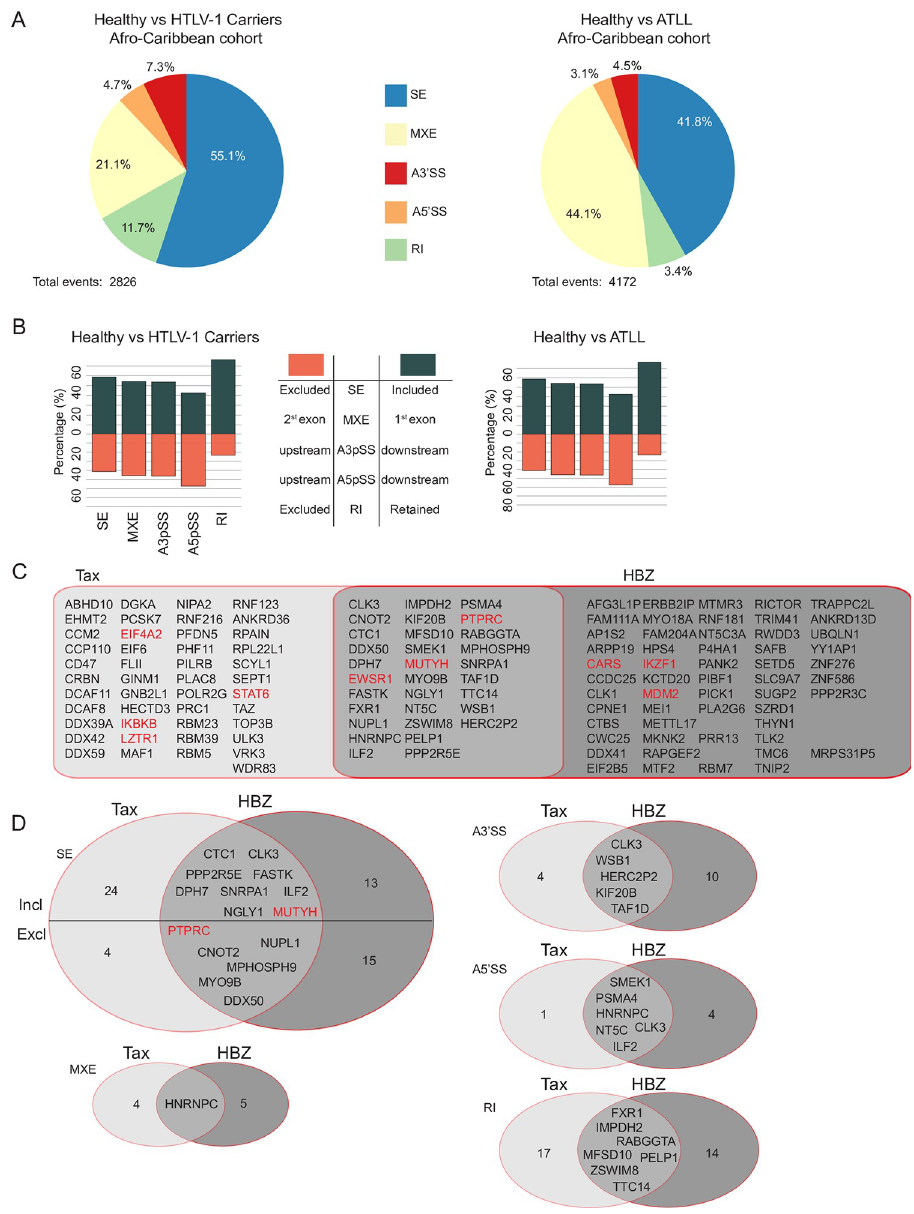
Fig 6. Splicing events in ATLL patients from the Afro-Caribbean cohort. (A) ASEs detected in HTLV-1 carriers or ATLL patients compared to healthy human peripheral CD4+ T cells. SE = Skipped Exon, MXE = Mutually Exclusive Exons, A3’SS = Alternative 3’ Splice Site, A5’SS = Alternative 5’ Splice Site, RI = Retained Intron (B) Exclusion or inclusion of ASEs observed in HTLV-1 carriers or ATLL. (C) Genes sharing similar ASEs in ATLL and Jurkat cells expressing Tax or Flag-HBZ. (D) Number of shared events. See also S3